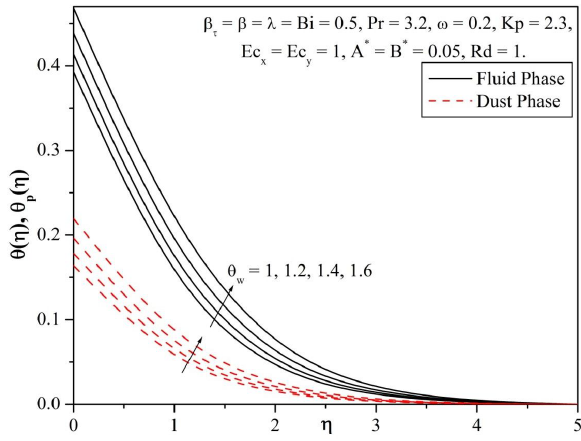
Fig. 19: Dimensionless temperature profiles for different values of θ w .